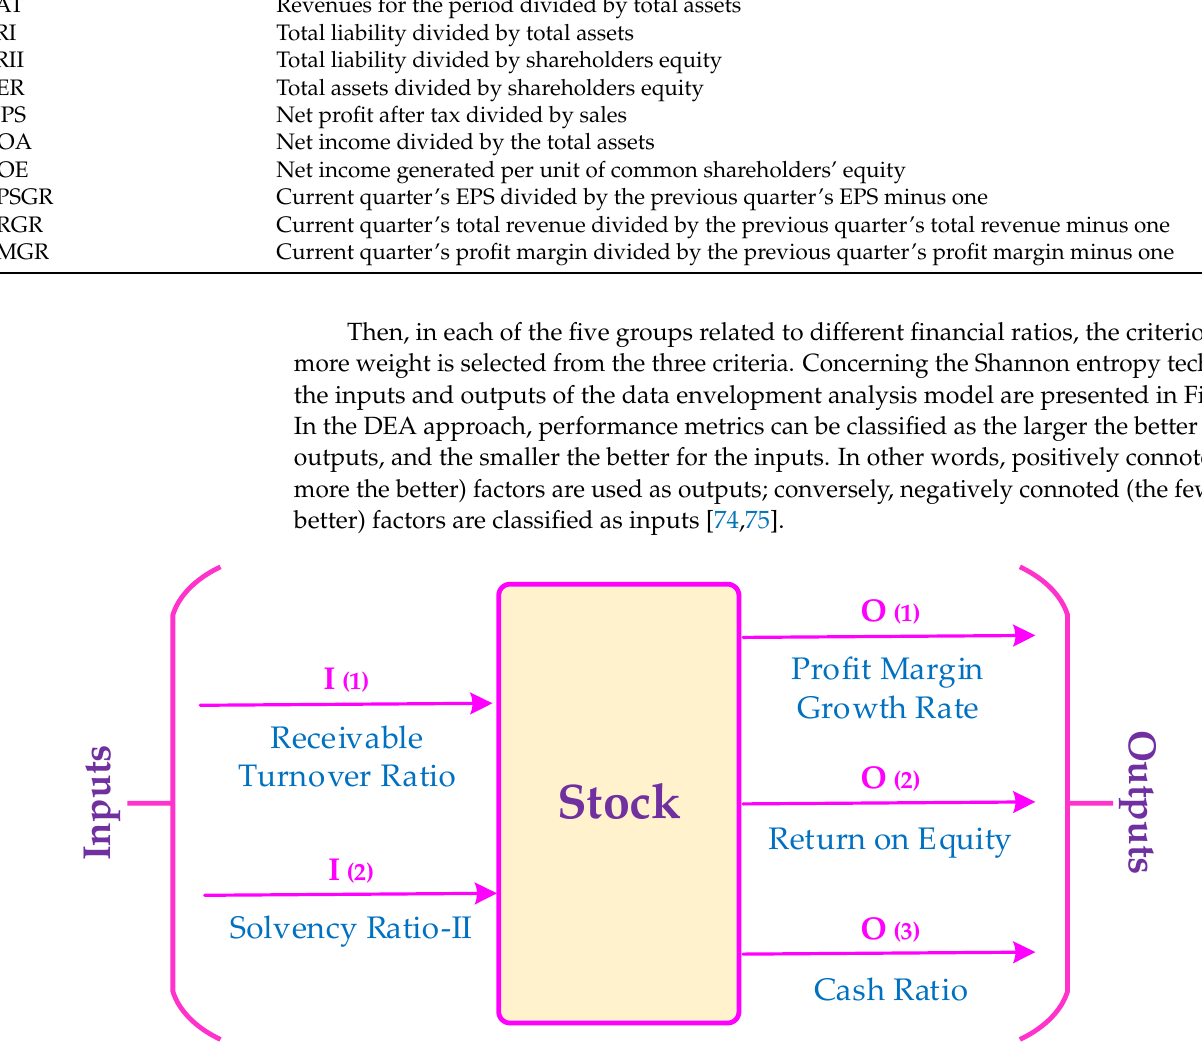
Figure 1. Selected inputs and outputs of RDM model for stock evaluation.